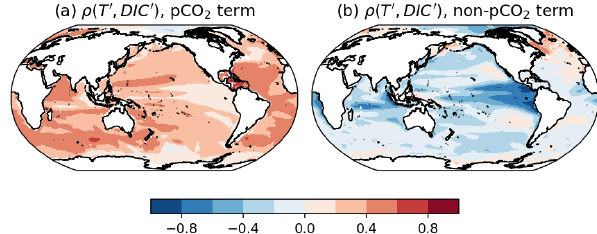
Figure 3. Breakdown of the correlation between upper-ocean DIC and temperature, ρ( DIC (cid:48) ,T (cid:48) ) , from Fig. 2d: (a) a term proportional to the variance of atmospheric p CO 2 and (b) a term consisting of the covariance of the residuals calculated after removing a linear fit against atmospheric p CO 2 . For a discussion of the breakdown of the correlation into terms and of the approximation, see Ap- pendix